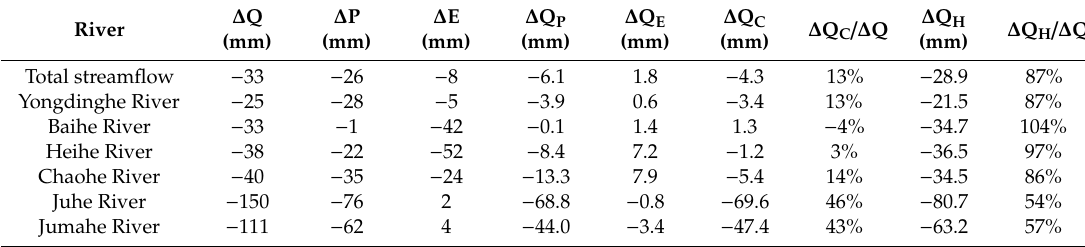
Table 3. Quantitative assessment of the impacts of climate change and human activities on the streamflow. ∆ Q ∆ River